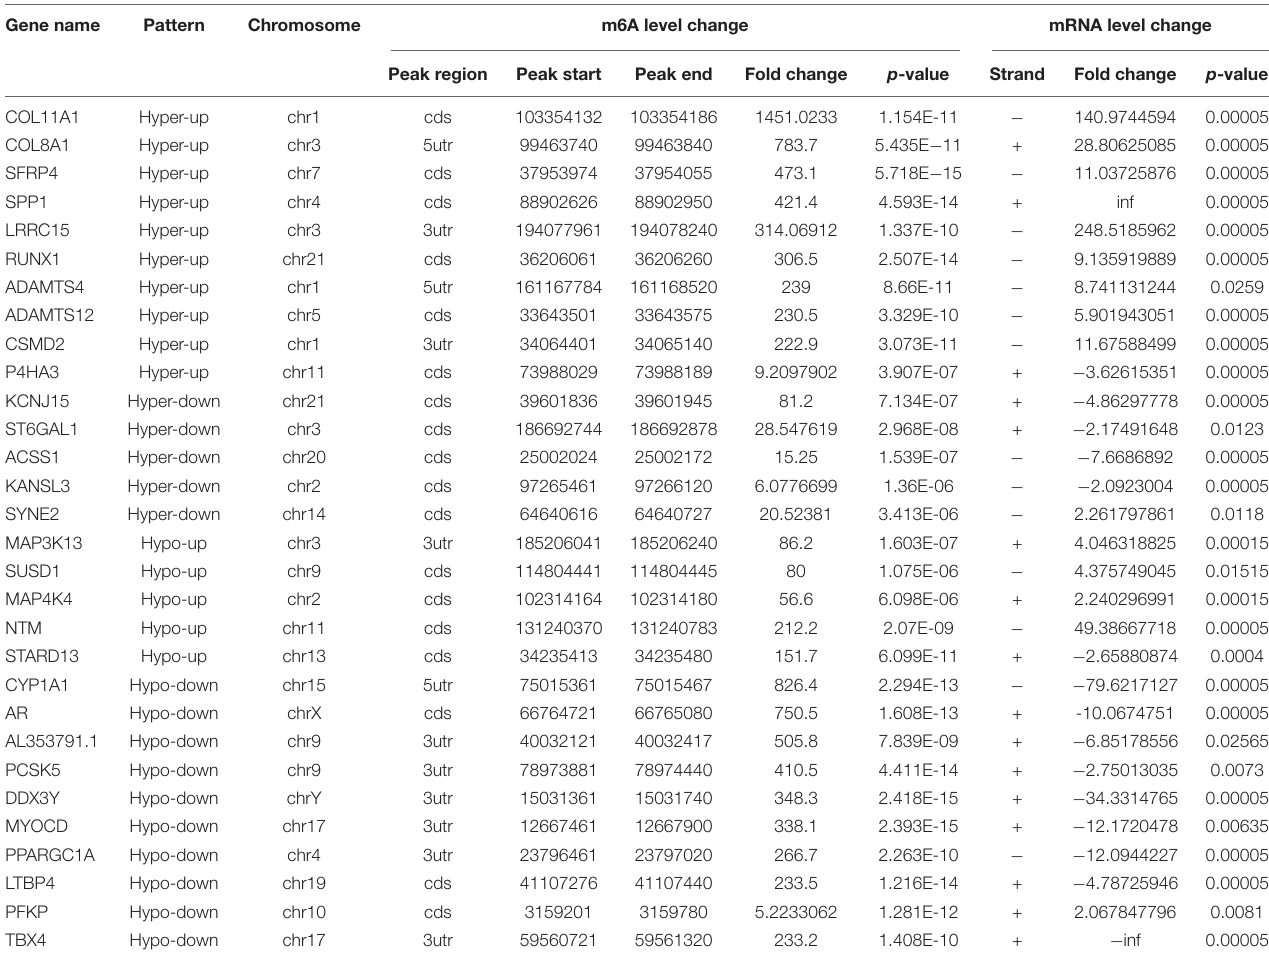
TABLE 5 | Thirty genes that exhibit a significant change in both m6A and mRNA transcript abundance (SC vs.